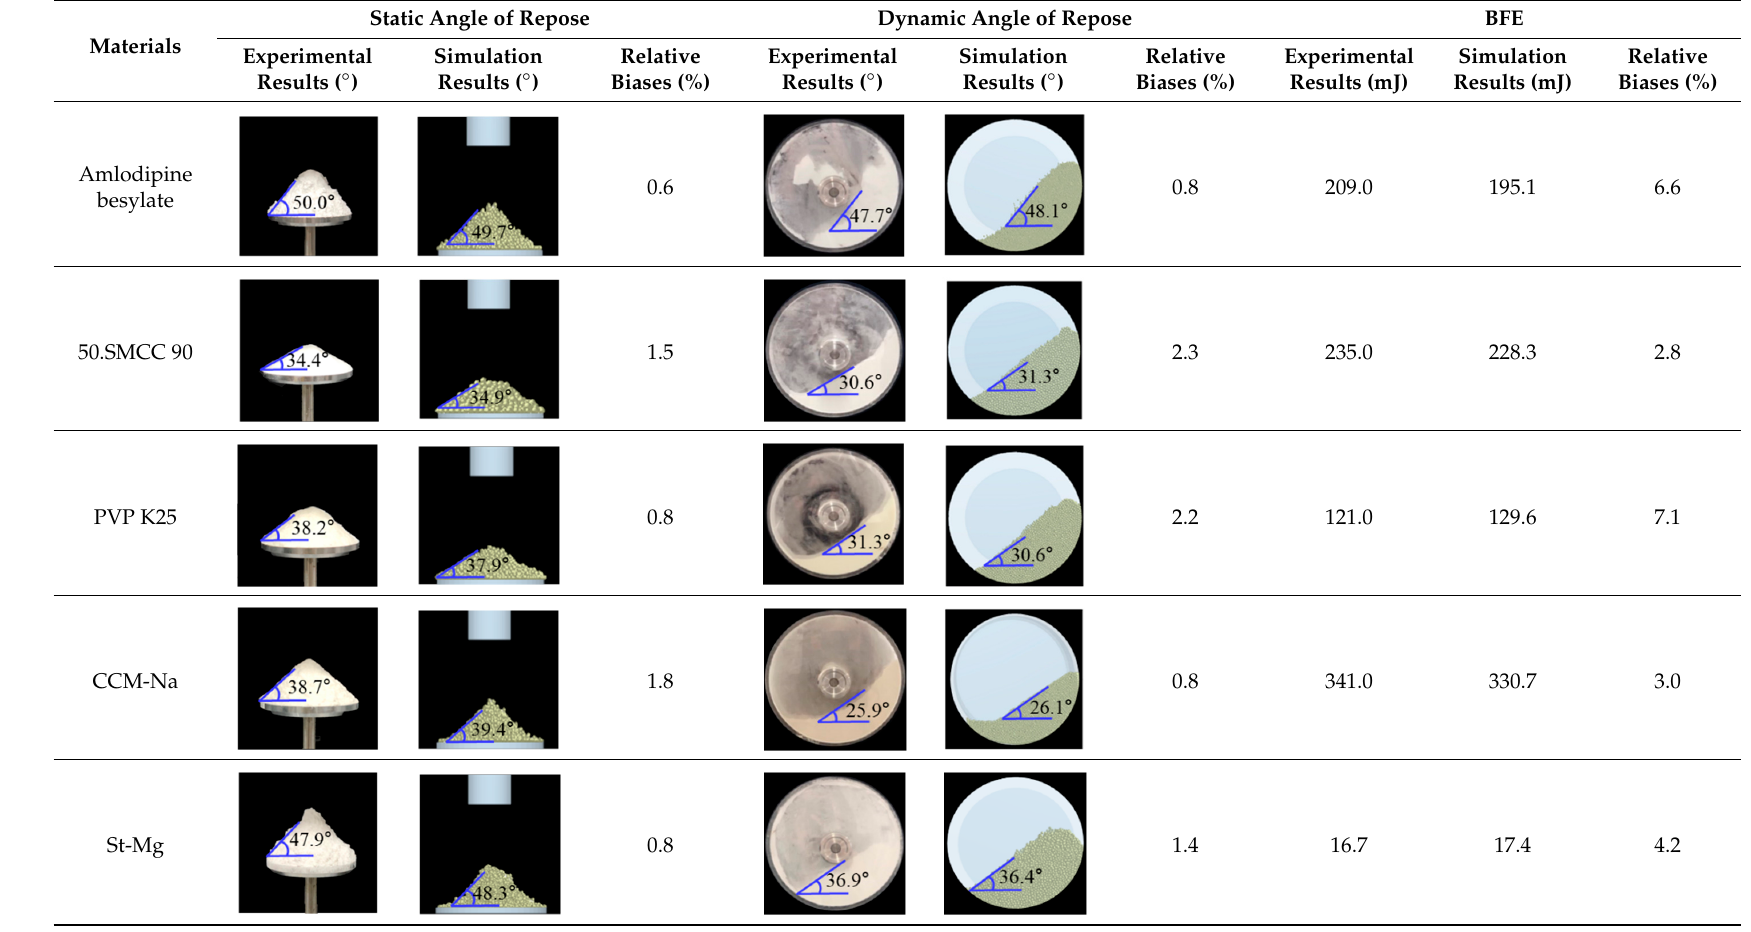
Table 6. Experimental results and simulation results of bulk tests for calibration